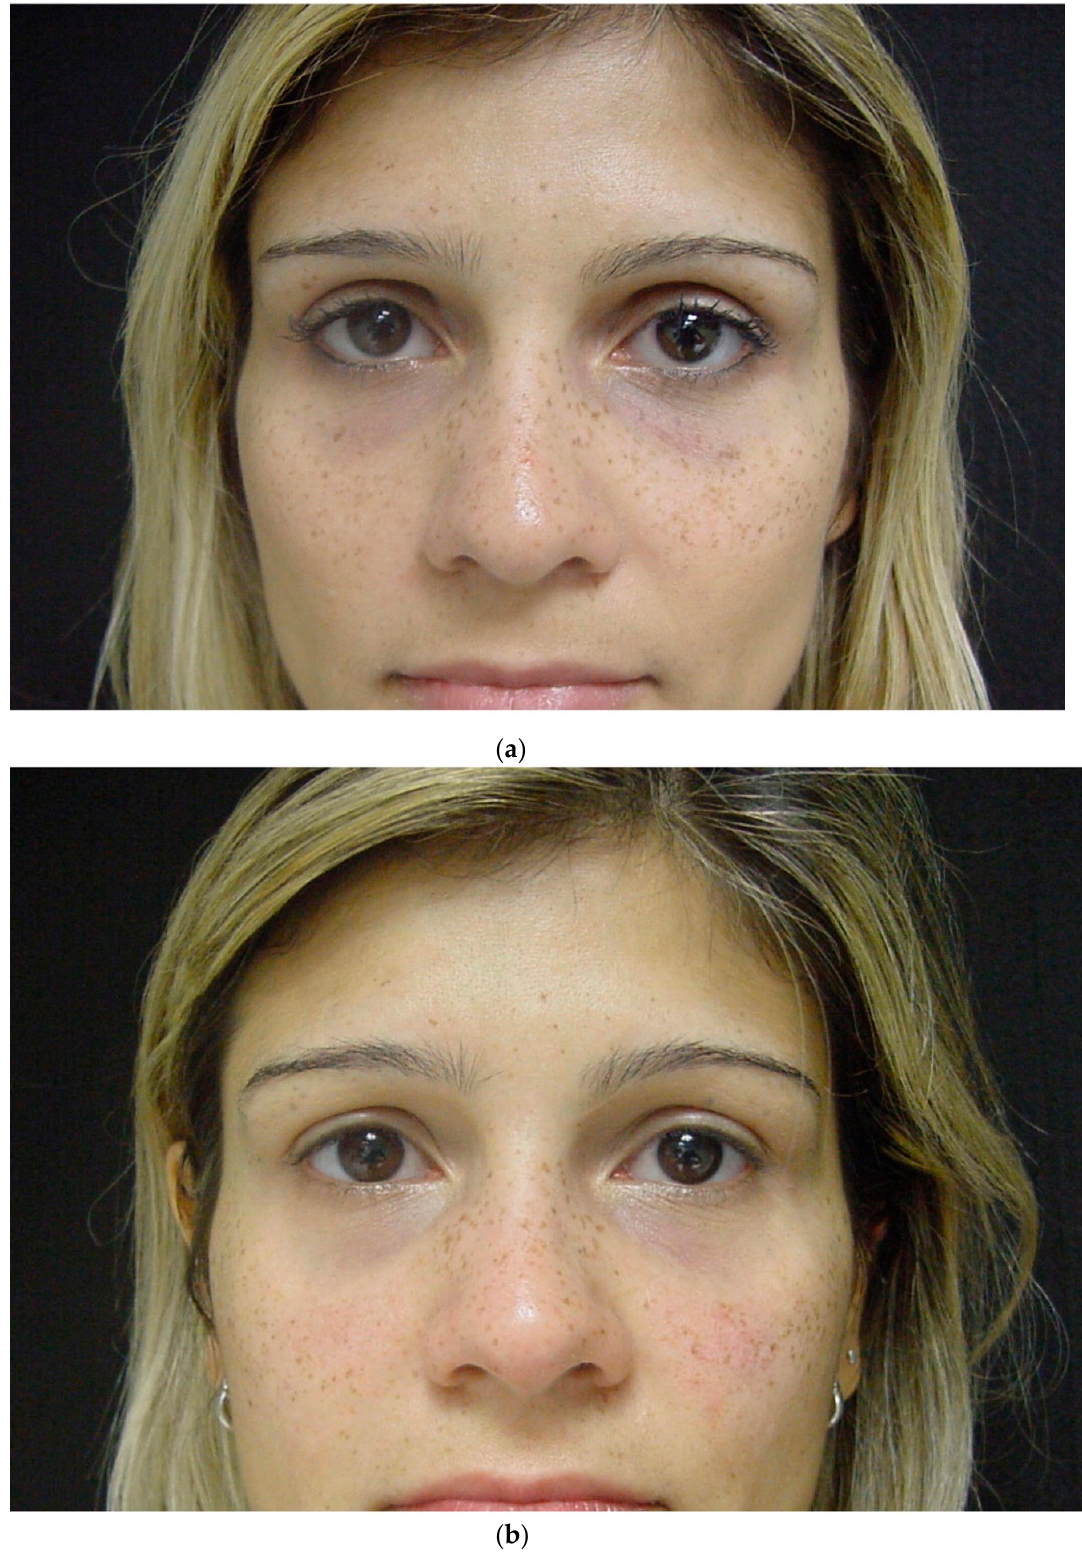
Figure 1. ( a )—31-year-old patient. Dark circles and freckles under the eyes. ( b )—Result after two sessions of 1064 nm Q-Switched Nd-YAG laser and IPL. Improvement of POH and freckles.